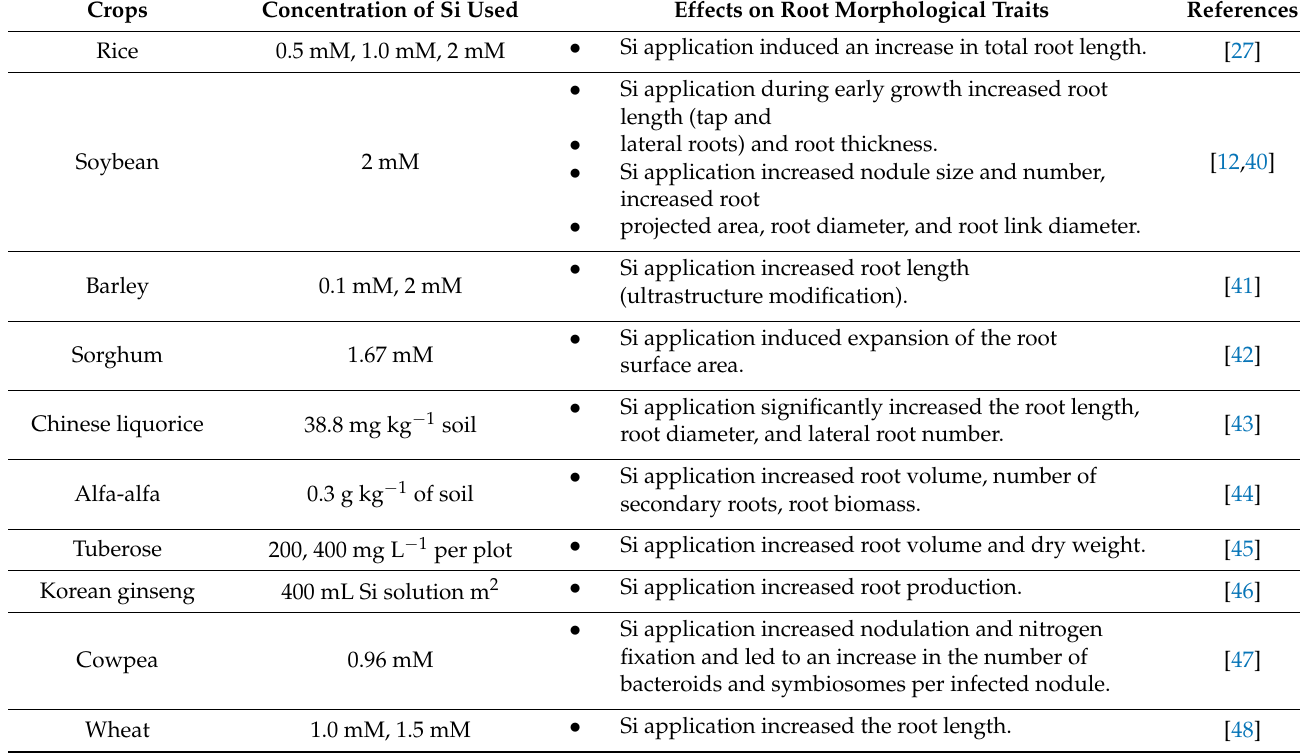
Table 1. Effects of Si application on root morphological traits. Effects on Root Morphological